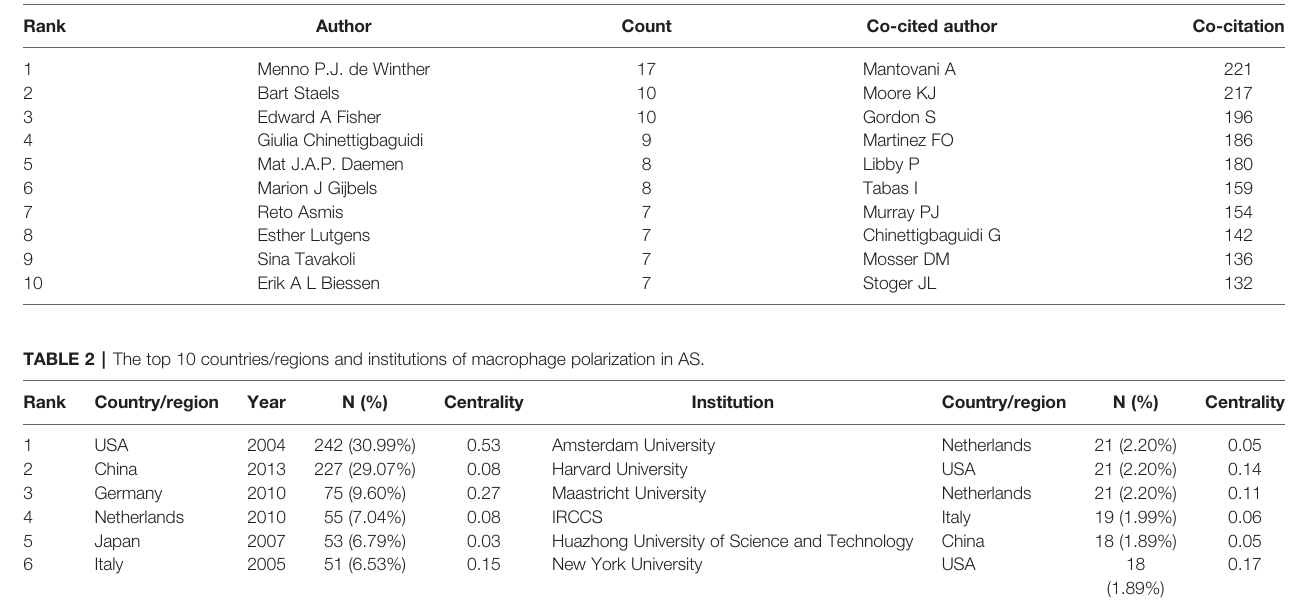
TABLE 1 | Top 10 authors and co-cited authors of macrophage polarization in AS research.